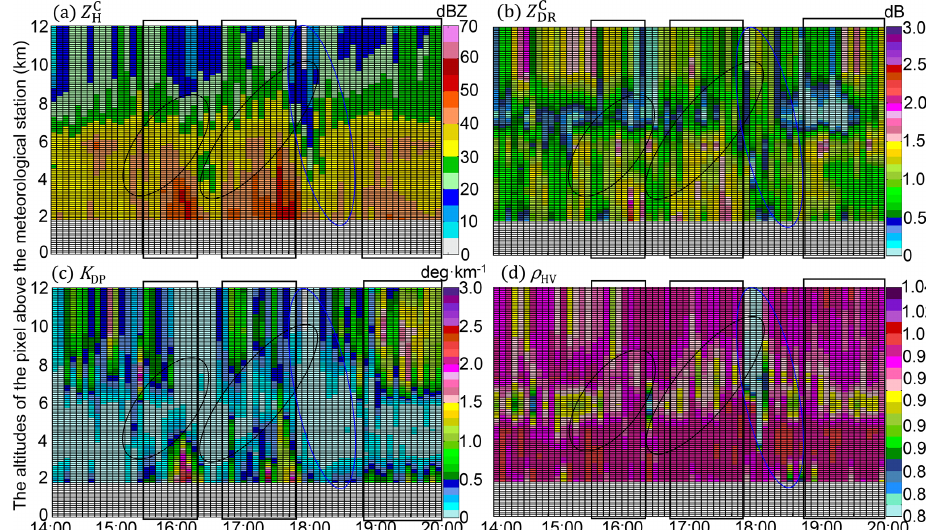
Figure 12. (a) Time series of vertical polarimetric radar variables upon the WL station between 14:00UTC, 8 August 2019, and 20:00UTC, 9 August 2019, (a) Z C , (b) Z C , (c) K DP , and (d) ρ HV . The black rectangles indicate developing convective storms, the black ellipses H DR surround the potential updrafts, and the blue ellipses surround the subsiding signatures of ice or mixed-phase particles.